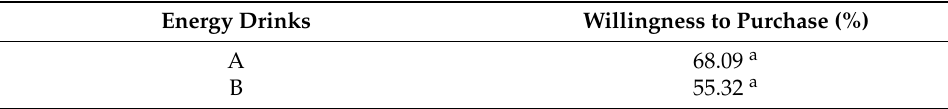
Table 3. Purchase intent frequencies of energy drinks during the tasting session. Energy Drinks